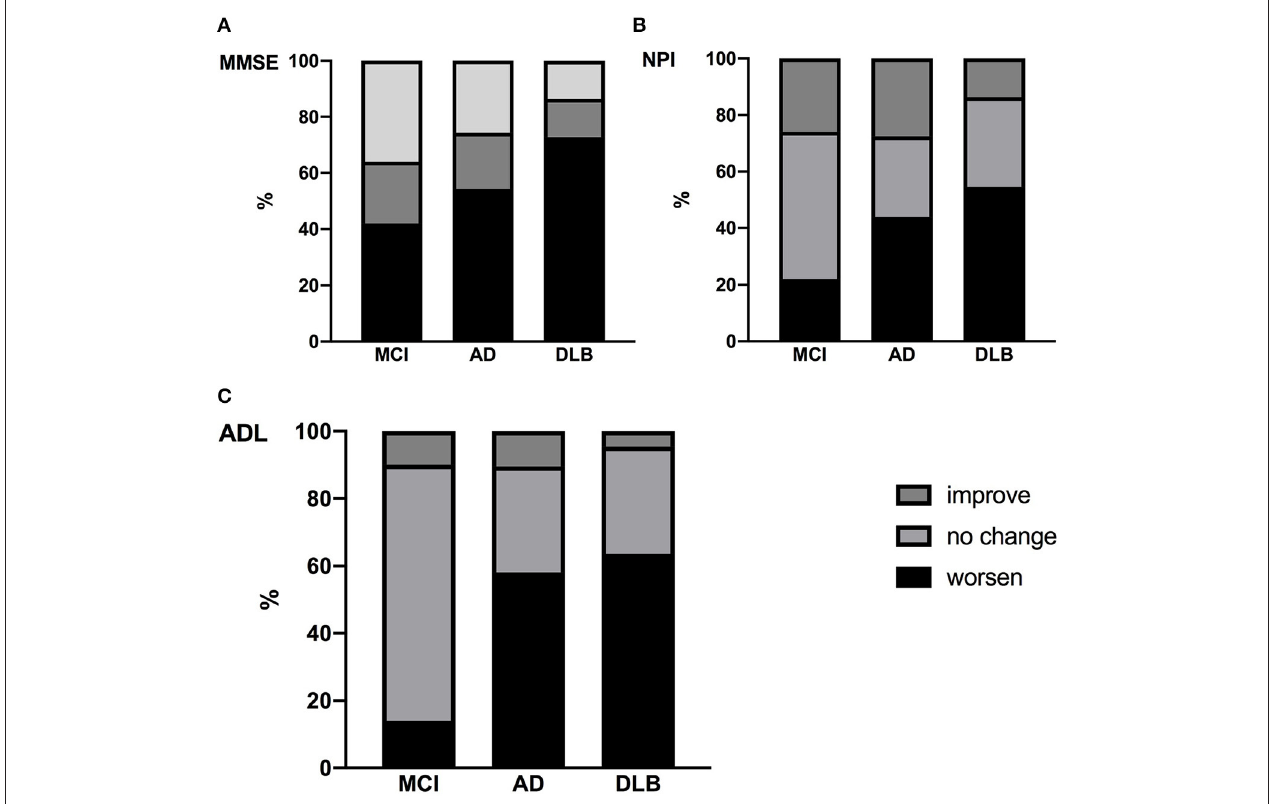
FIGURE 2 | Comparison of changes in Mini-Mental Status Exam (MMSE) (A) , neuropsychiatric inventory (NPI) (B) and activities of daily living (ADL) (C) in three groups.